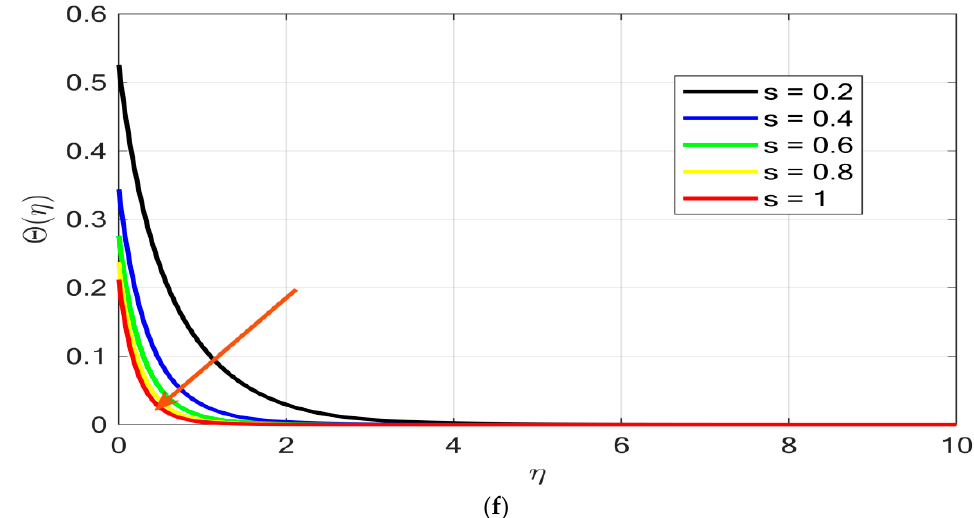
Figure 9. ( a – f ) Demonstration of distinct varying parameters on study profiles. ( a ) Influence of rotational ratio on primary velocity; ( b ) impact of rotational ratio on primary velocity; ( c ) impression of rotational ratio on primary velocity; ( d ) depiction of rotational ratio on primary velocity; ( e ) influence of Prandtl number on temperature profile; ( f ) effect of unsteadiness on temperature profile.